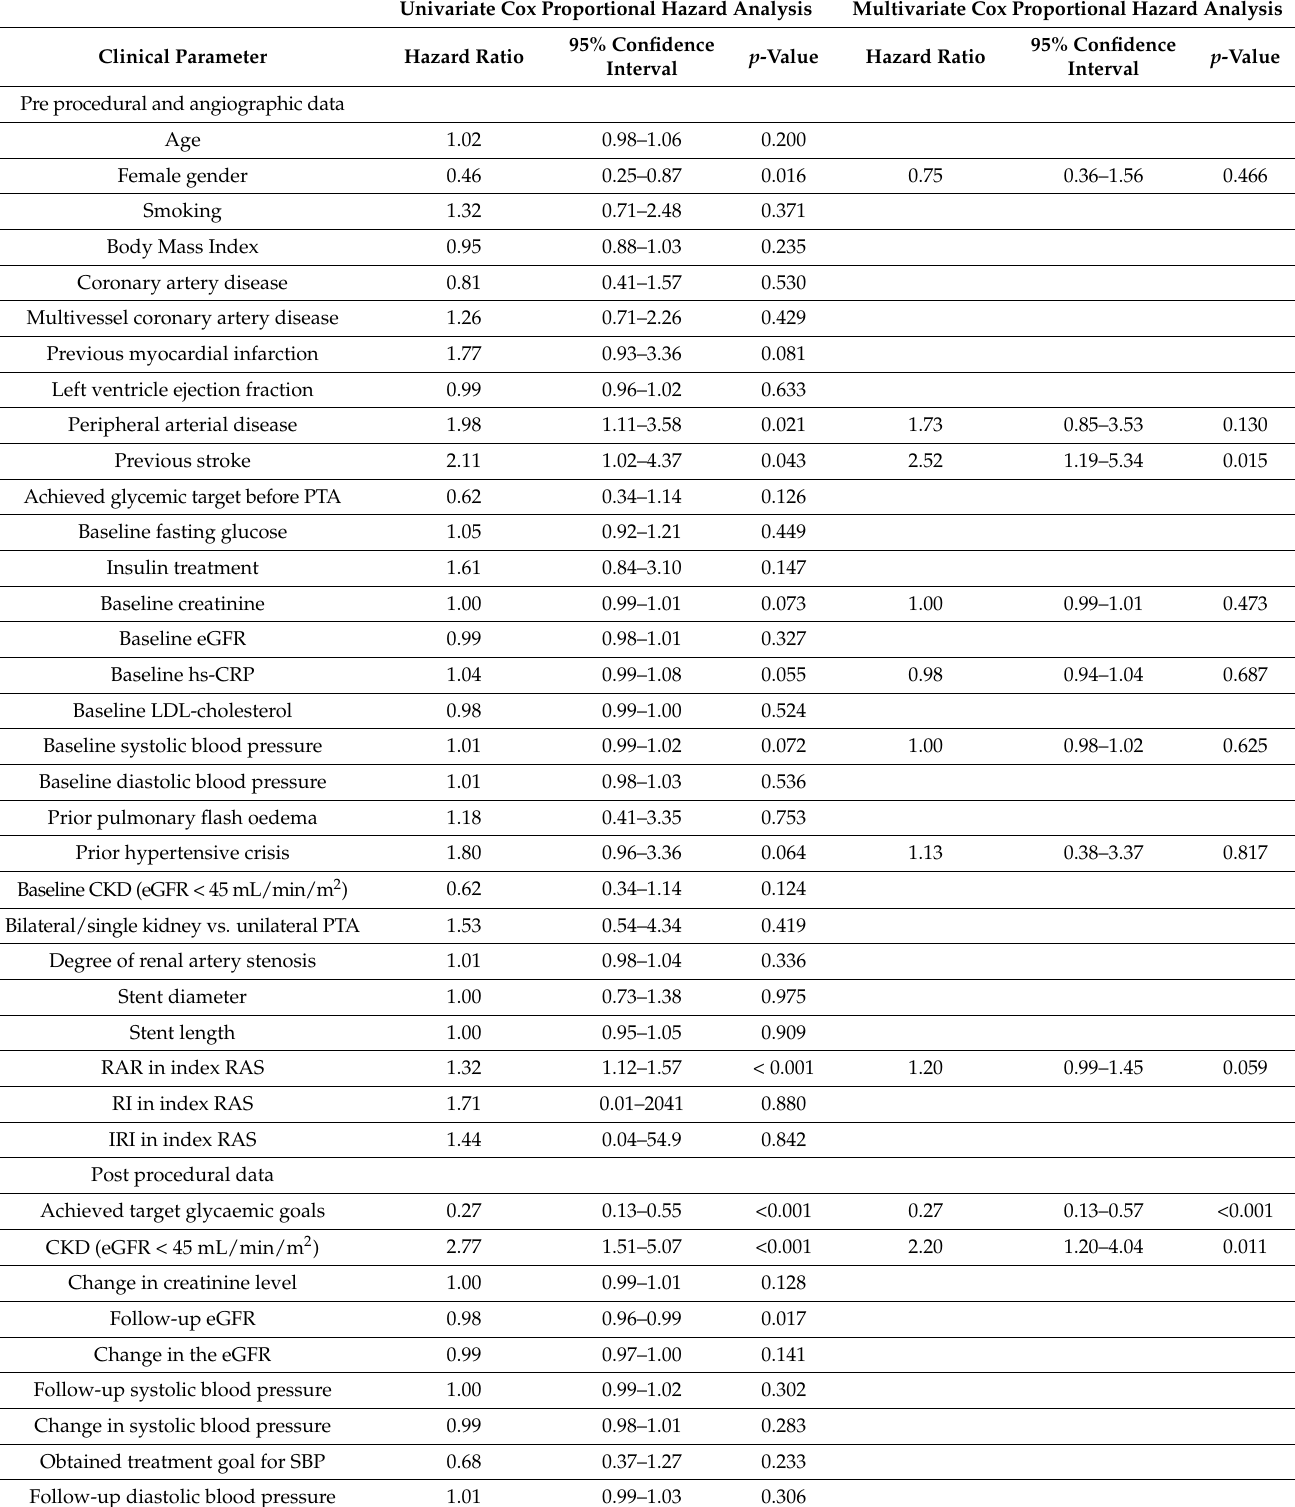
Table 3. Univariate and multivariate Cox proportional hazard analysis for the incidence of major cardiac and cerebral events and renal replacement therapy following endovascular treatment for atherosclerotic renal artery